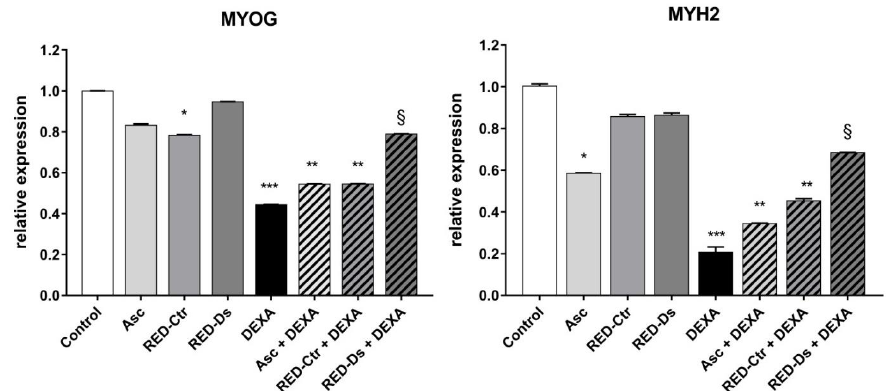
Figure 7. Gene expression of late Myosin heavy chain-2 (MYH2) and Myogenin (MYOG) muscle cell markers, normalized to three most stable reference genes, eEF1a, RPL13a and B2M, (Avg M value = 0.269). The 2 −ΔΔCt algorithm was applied for relative quantification in differentiated myotubes. Differentiated myotubes were treated with 50 μM of DEXA or with 5μg GAE/mL (TPC) of ascorbic acid (Asc) and Rosso di Pitigliano (RED) extracts of plants grown in normal (RED-Ctr) or in drought stress conditions (RED-Ds), for 48 h. Data show relative expression to the untreated cells (control). * p < 0.05, ** p < 0.005 and *** p < 0.001 vs. control; § p < 0.05 vs. DEXA using one-way ANOVA.